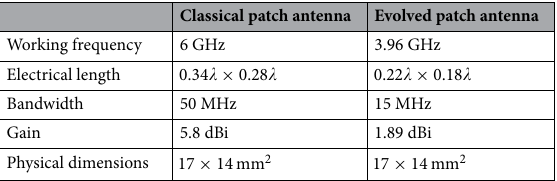
Table 3. Comparison between a classical and the evolved patch antenna.